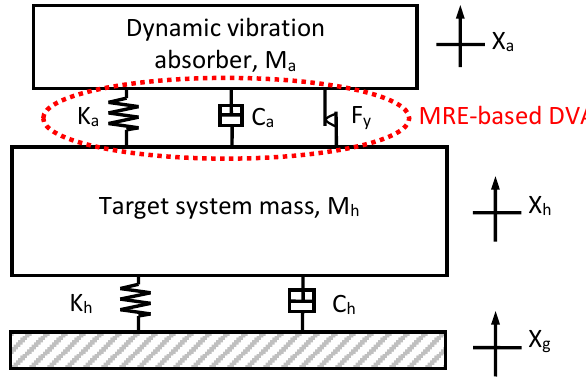
Figure 4: Mechanical model of the MAD-LRA in the absence of magnetic field input. Figure 11. Equivalent mechanical model of the